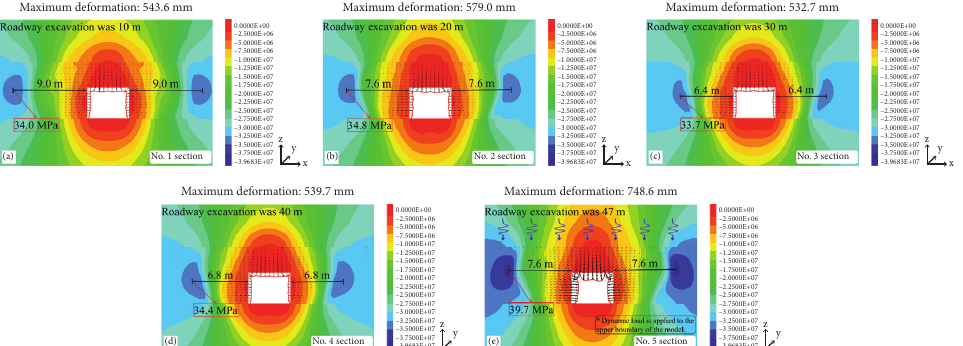
Figure 9: Distribution of surrounding rock stress and displacement during roadway excavation. Roadway excavation was (a) 10m, (b) 20m, (c) 30m, (d) 40m, and (e)